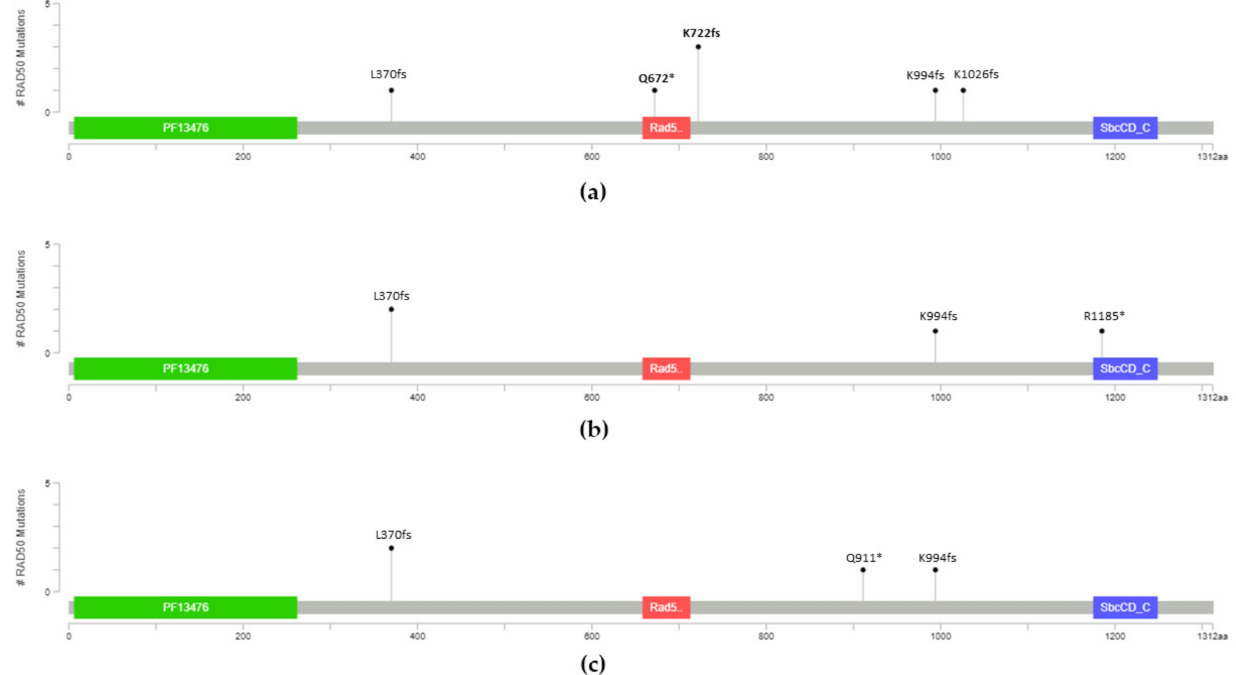
Figure 1. Lollipop schematic diagram of RAD50 LOF mutation distribution in ( a ) familial ESCC cases, ( b ) sporadic ESCC cases, and ( c ) controls from Henan. * stands for stop gain